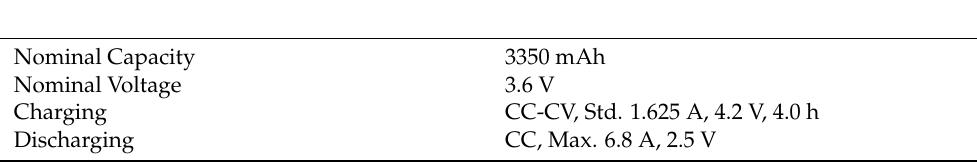
Table 1. Specifications of NCR 18650B battery by